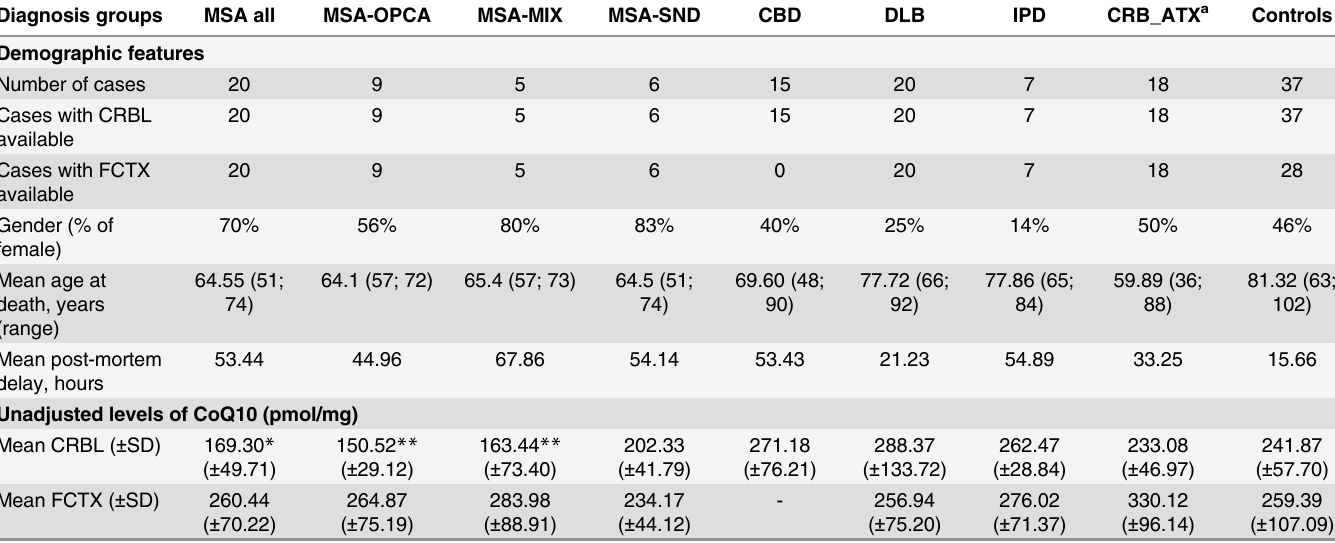
Table 1. Characterization of the samples included in this